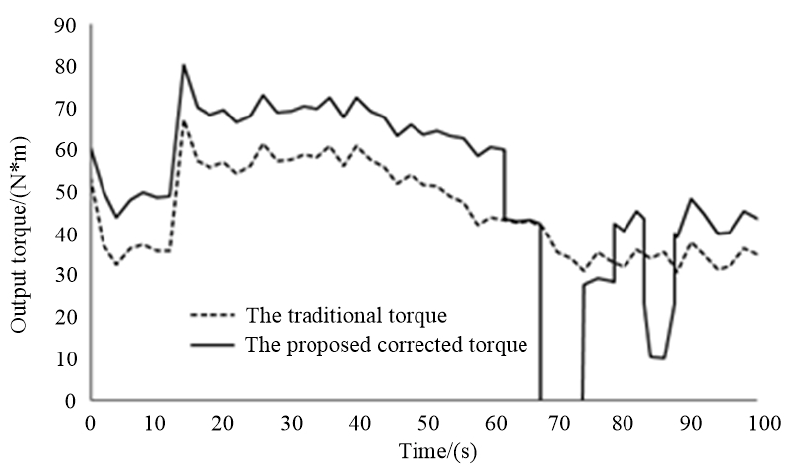
Figure 17. Comparison of output torque via the two methods.